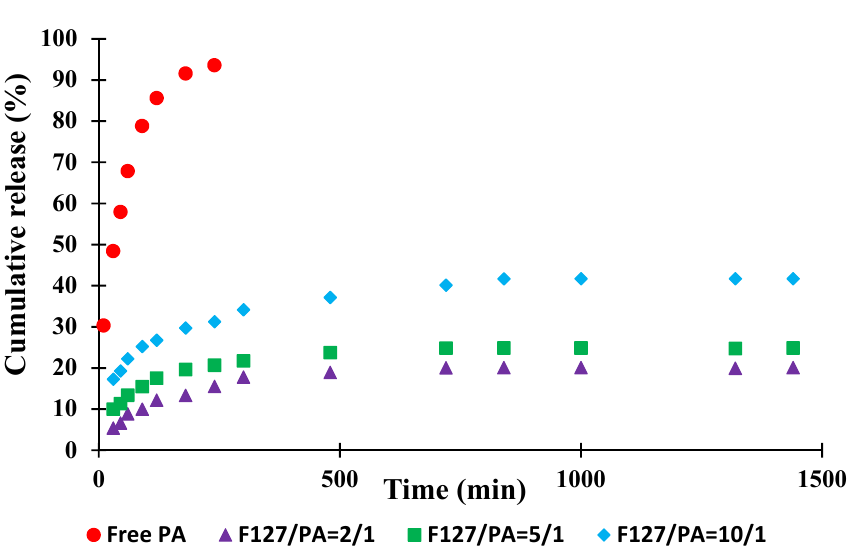
Figure 4. Evolution of the cumulative release kinetics in PBS (pH = 7.4) at 37 °C.